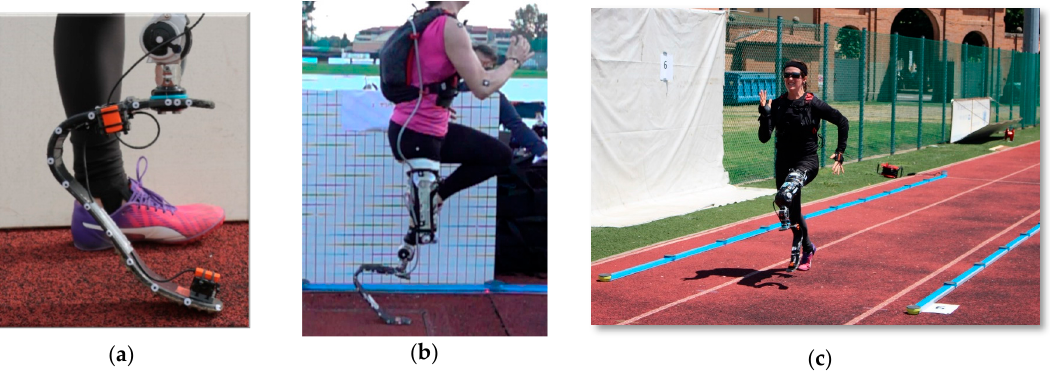
Figure 3. Field tests setup: ( a ) Inertial suit from Xsens applied to the athletes, with detail of the RPF arrangement of sensors, ( b ) running validation tests with simultaneous collection of GRF from a force platform in the track and the iRPF. ( c ) Sprint tests on track without force